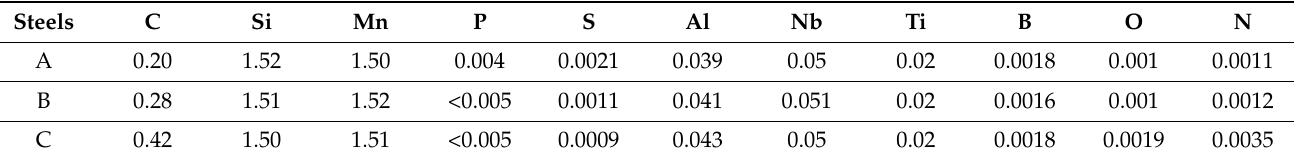
Table 1. Chemical compositions (mass%) of steels.